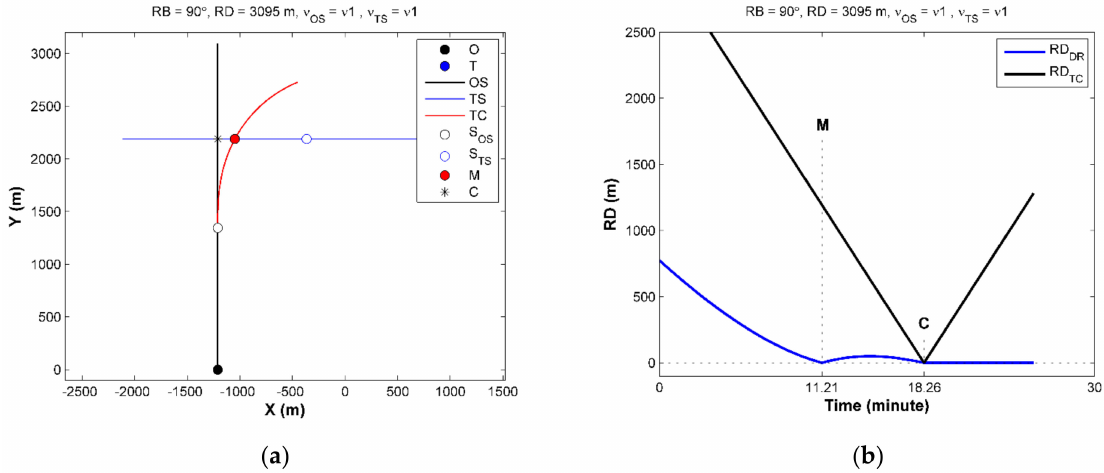
Figure 12. Estimation results for Scenario 3 (encountering angle of 90): ( a ) OS-TS encounter and collision points; ( b ) Estimation of the OS-TS relative distance and the time at collision Points C and M over time.